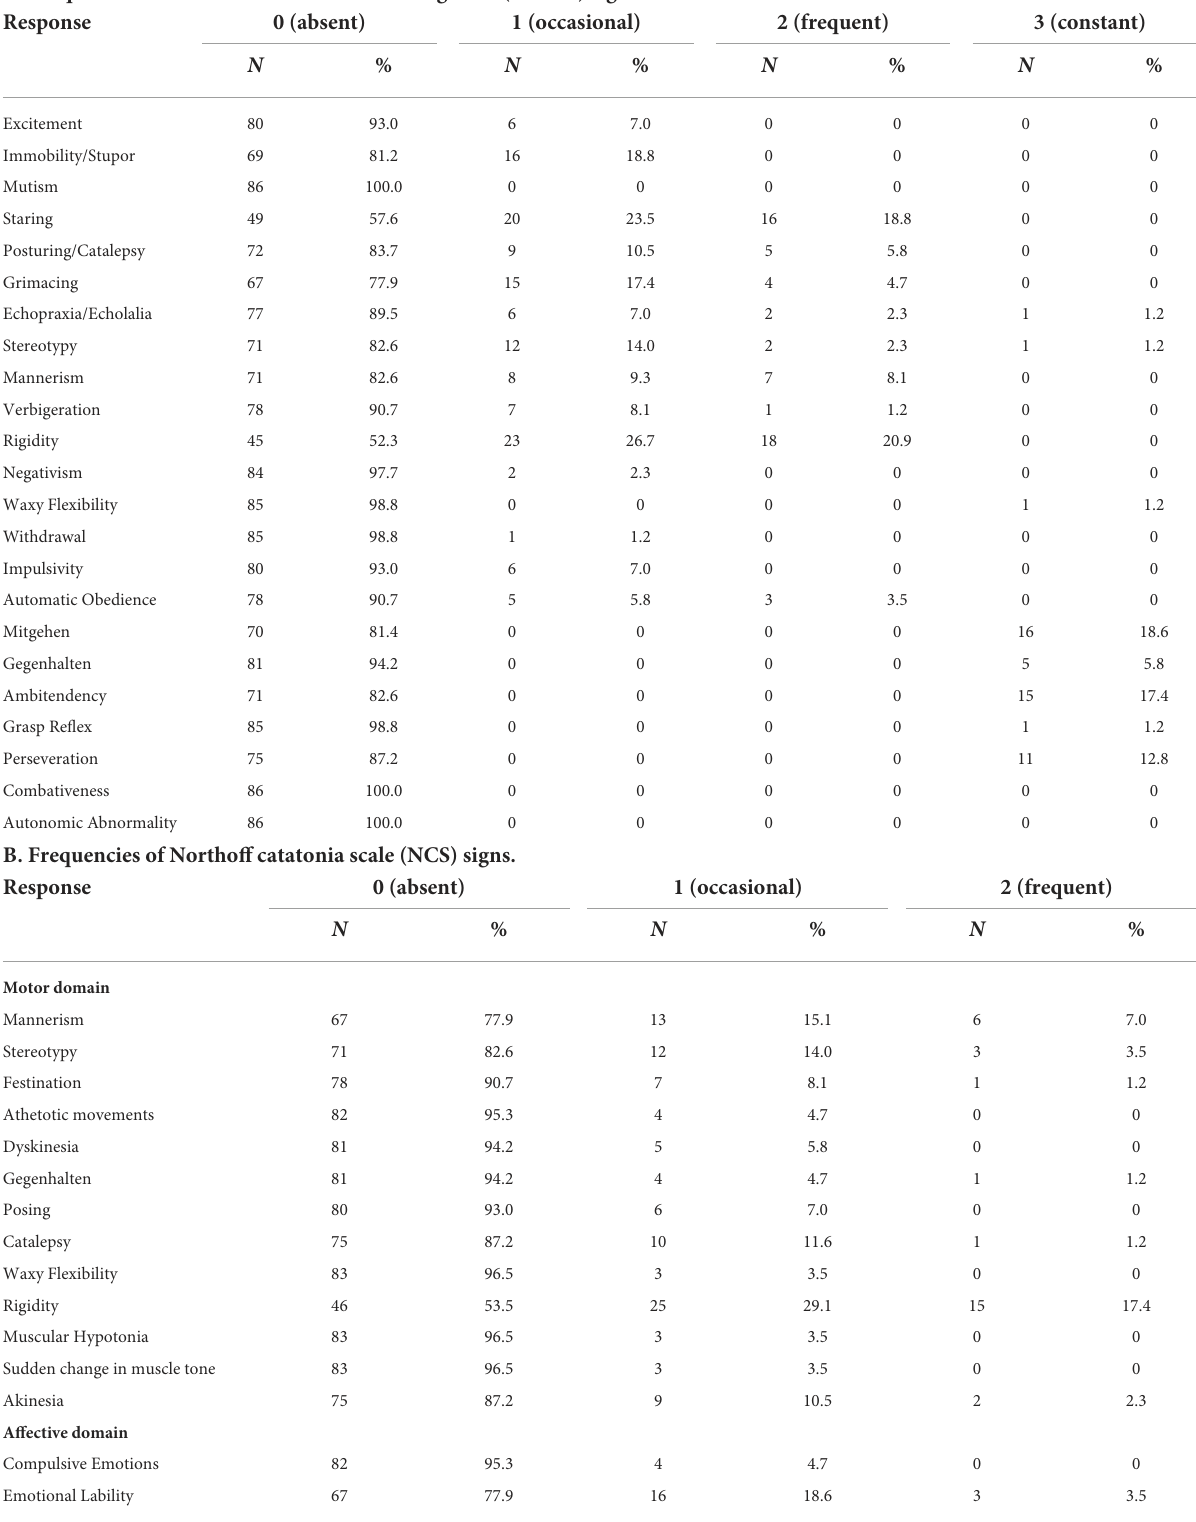
TABLE 2 Frequencies of catatonia signs. A. Frequencies of Bush Francis catatonia rating scale (BFCRS)